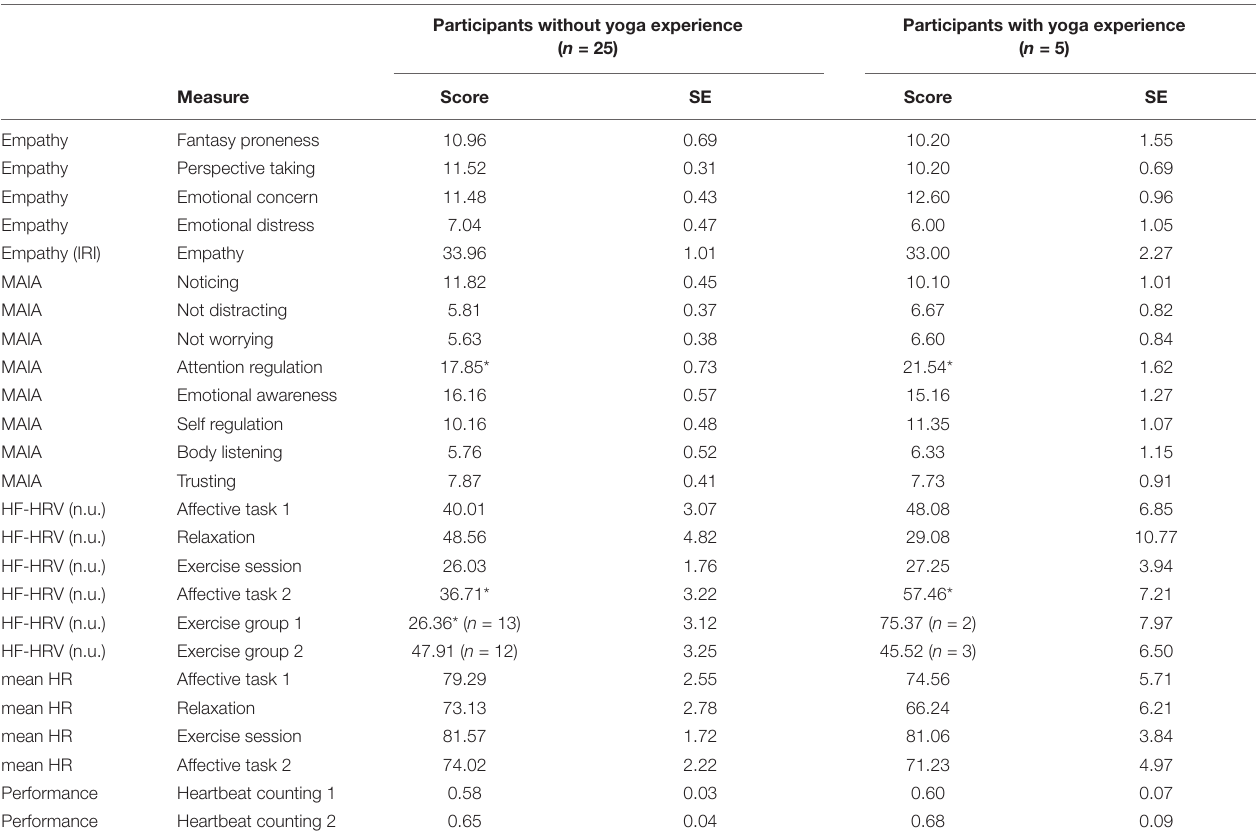
TABLE 2 | Exploratory analysis: Descriptive statistics and comparisons between participants without self-reported yoga experience and participants with self-reported yoga experience.